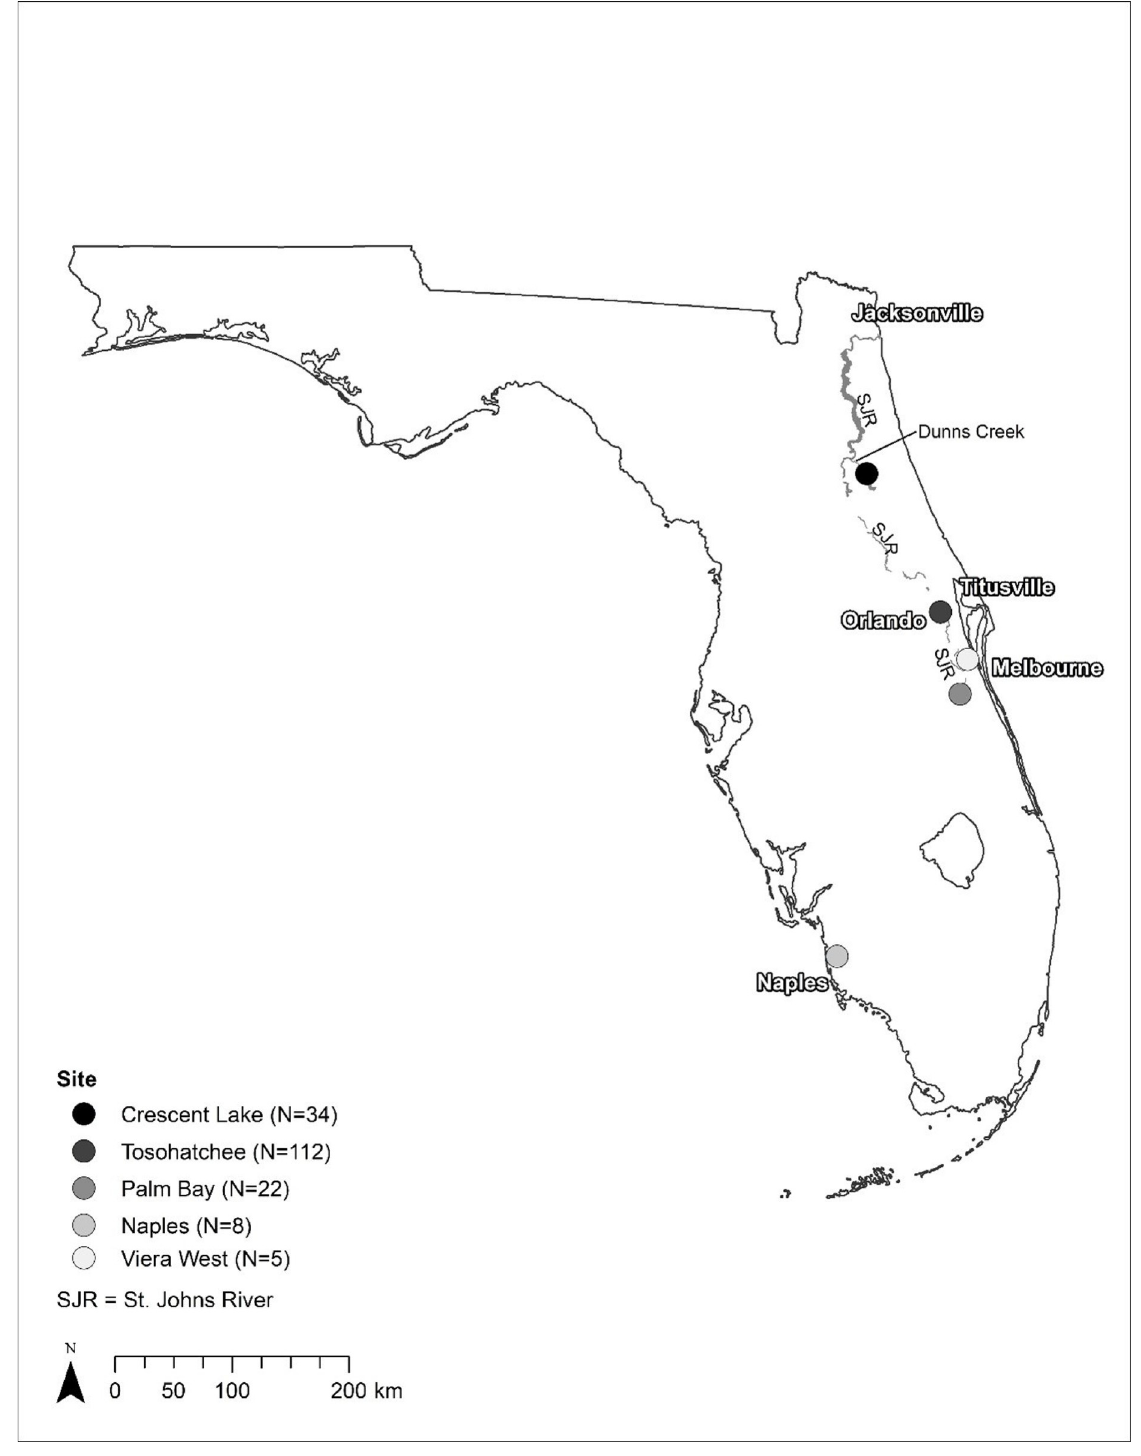
Fig 1. Locations of sampled free-ranging turtles from 13 March 2018 to 27 February 2019, and 23–24 March 2020. Numbers represent the estimated counts of sick and dead turtles reported from these regions, as detailed in Table 1.